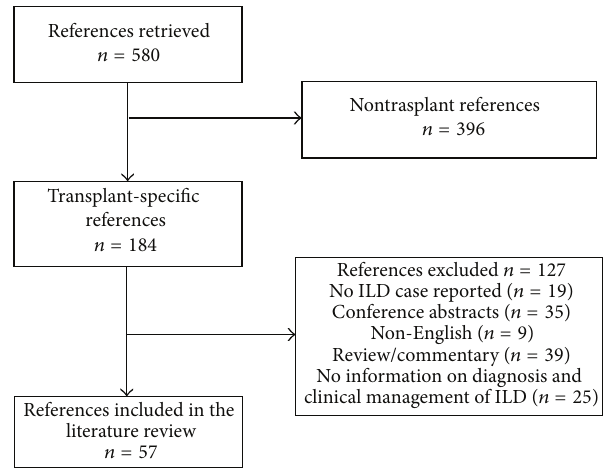
Figure 2: Literature search flow